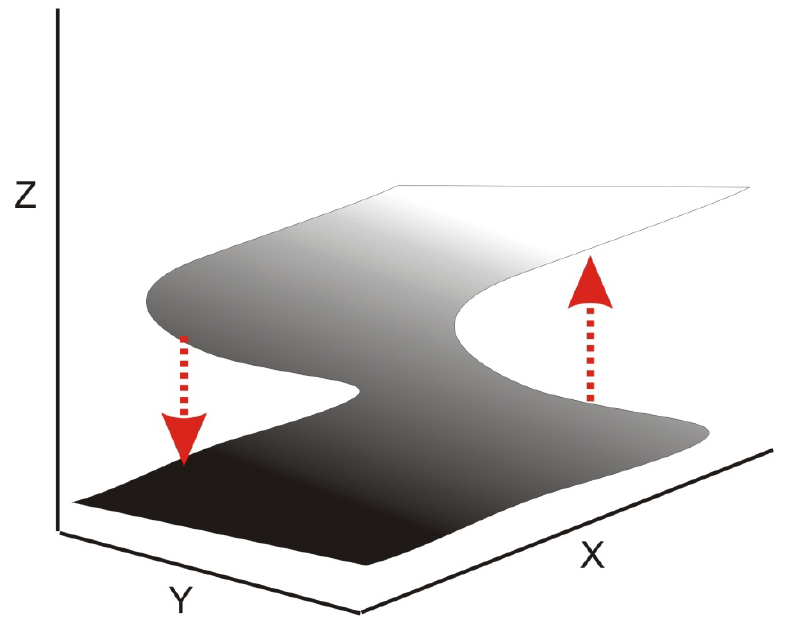
Figure 2. A representation of catastrophe theory [10]. We could interpret the down arrow as a catastrophe and the up arrow as a